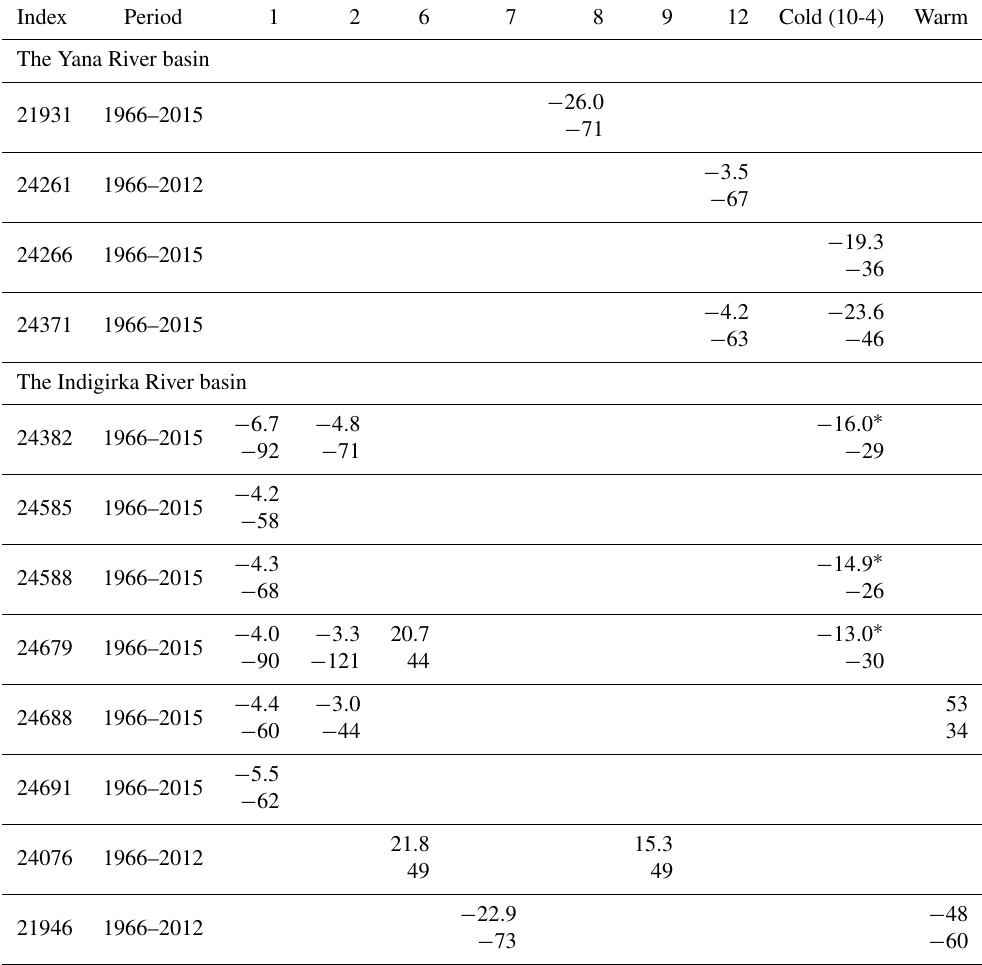
Table 4. Changes in monthly, seasonal, and annual precipitation (millimeters and percent),